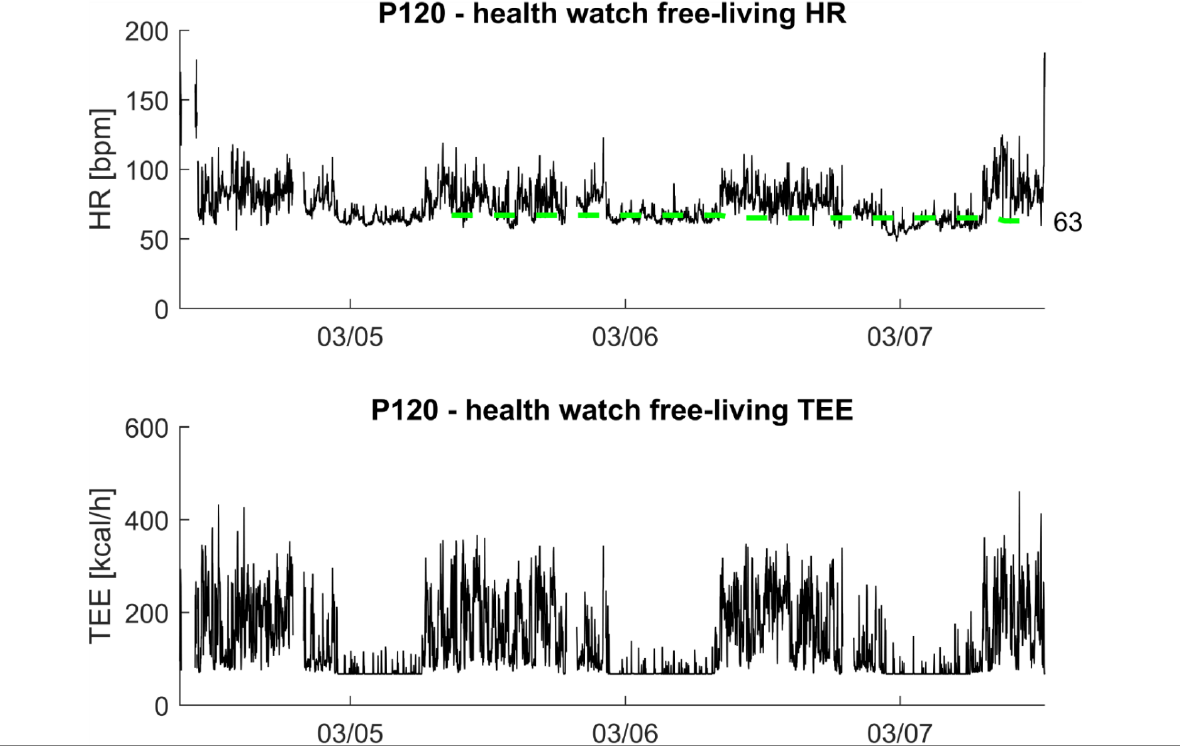
Figure 4. Example of free-living heart rate (HR), resting heart rate, and total energy expenditure (TEE) for participant P120. Top: Philips health watch HR as a function of time for the free-living portion of the trial (black) and the resting heart rate from the health watch (green dashed line; note that resting heart rate requires a 24-hour assessment and therefore day 1 does not have a resting heart rate value). Bottom: TEE as a function of time for the free-living portion of the trial. bpm: beats per